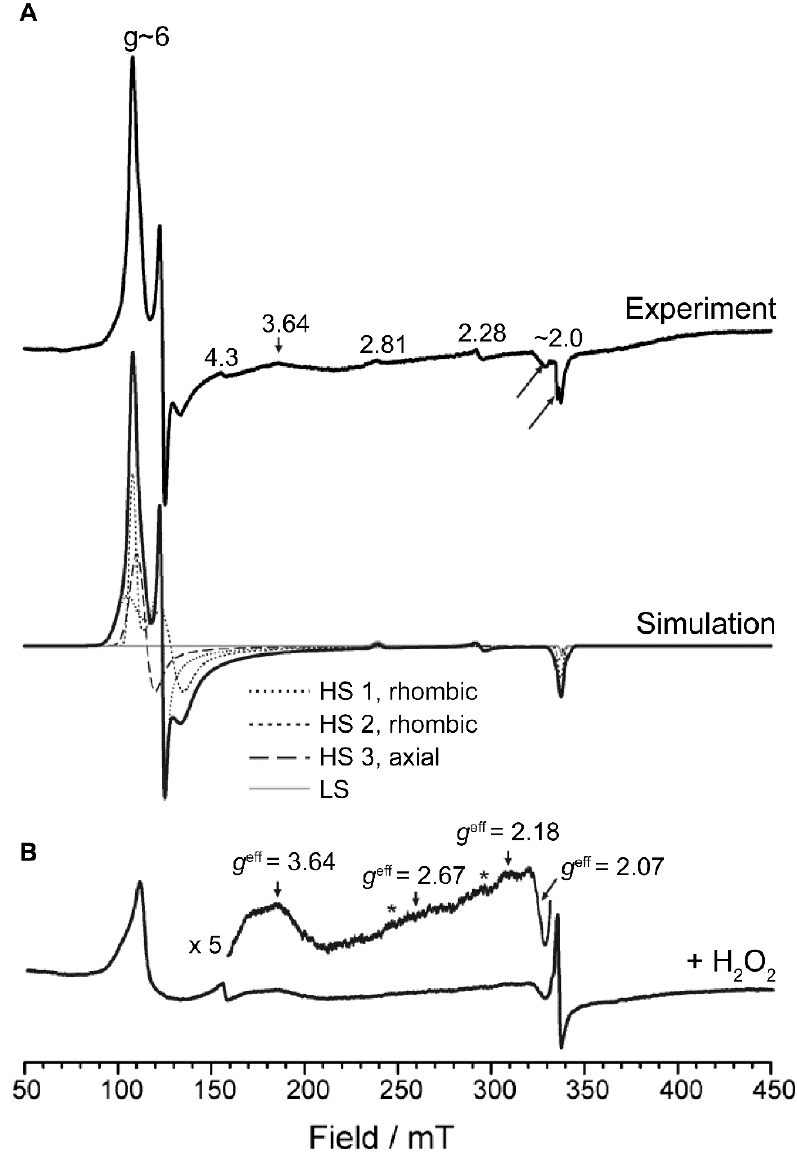
Figure 2. EPR spectrum of Dictyostelium DyPA. ( A ) EPR spectrum of Dictyostelium DyPA (top) and simulated spectrum (bottom, black, and solid). The single-component spectra of the simulation are shown as dotted lines (HS 1), short dashed lines (HS 2), dashed lines (HS 3), and in grey (LS). The signal at g = 4.3 is caused by a small amount of adventitious iron. Two features in the g = 2 (arrows) region are due to a cavity contaminant. A baseline distortion evident mainly in the region 150 – 400 mT originates from a small amount of solid air in the sample tube. ( B ) Dictyostelium DyPA incubated for 5 s with 3 mM H 2 O 2 . The experimental conditions were equal to those used for obtaining the spectrum in panel A. Spurious amounts of LS left after H 2 O 2 treatment are marked by stars in the inset. The experimental spectra in panels A and B are drawn to scale.